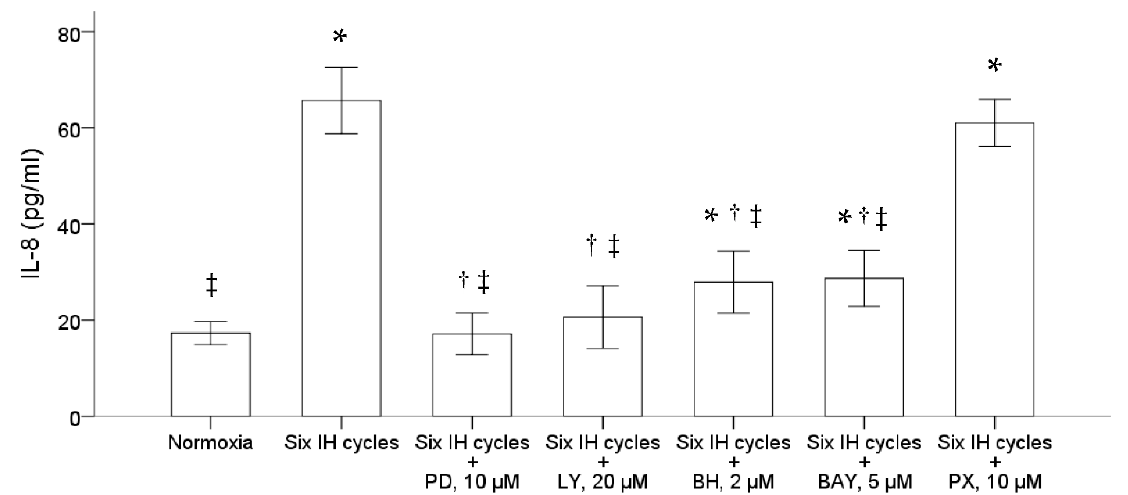
Figure 3. Intermittent hypoxia induced activation of the ERK, PI3K, PKC and NF- κ B signal pathways in the THP-1 cells. The THP-1 cells were treated with normoxia or six cycles of intermittent hypoxia and the culture medium was collected for the enzyme-linked immunosorbent assay. PD98059, LY294002, bisindolylmaleimide I hydrochloride, Bay11-7082 and PX-478, inhibitors specific for the ERK, PI3K, PKC, NF- κ B and HIF-1 α pathways, respectively, were then used to pretreat the monocytic THP-1 cells one hour before the condition of intermittent hypoxia. The results demonstrated that pretreatment with either 10 μ M PD98059, 20 μ M LY294002, 2 μ M bisindolylmaleimide I hydrochloride and 5 μ M Bay11-7082 diminished the IL-8 production induced by intermittent hypoxia. Note: The data were presented as the means and the standard errors from three independent experiments, * p < 0.05 vs. normoxia; † p < 0.05 vs. six IH cycles; ‡ p < 0.05 vs. six IH cycles + PX 10 μ M. Abbreviations: BAY = Bay11-7082; BH = bisindolylmaleimide I hydrochloride; IH = intermittent hypoxia; IL = interleukin; LY = LY294002; PD = PD98059; PX = PX-478.